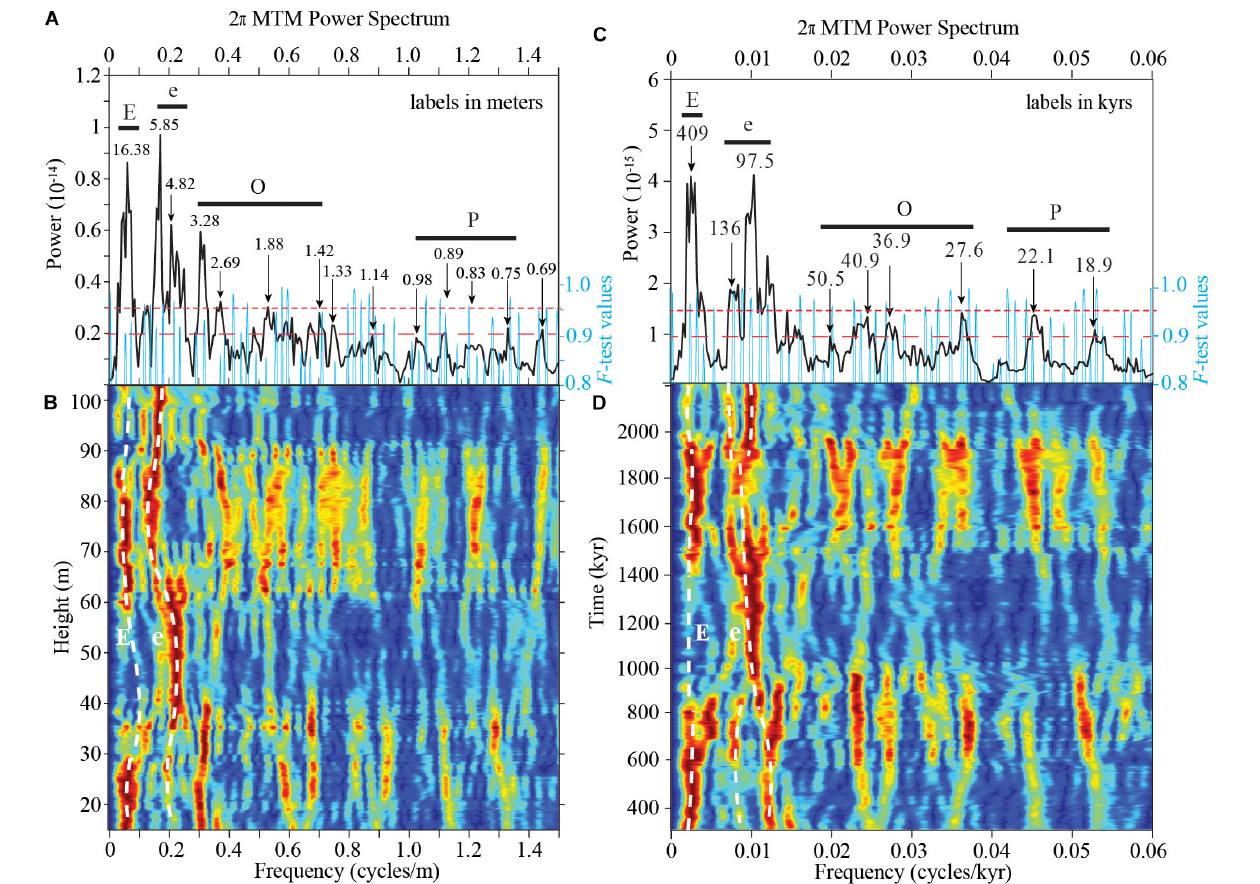
FIGURE 4 | Spectral analysis of the DBG MS stratigraphic series and 405-kyr-tuned series, frequency range: f = (0, 1.5 cycles/m) and f = (0, 0.06 cycles/kyr). (A) 2 π MTM power spectrum of MS stratigraphic series with F -test values for significant harmonic lines. (B) Evolutionary FFT spectrogram of MS stratigraphic series with a 30 m sliding window. (C) 2 π MTM power spectrum of 405-kyr-tuned MS series with F -test significance values for harmonic lines. (D) Evolutionary FFT spectrogram of 405-kyr-tuned MS series with a 600 kyr sliding window. E, long orbital eccentricity; e, short orbital eccentricity; O, obliquity; P, precession